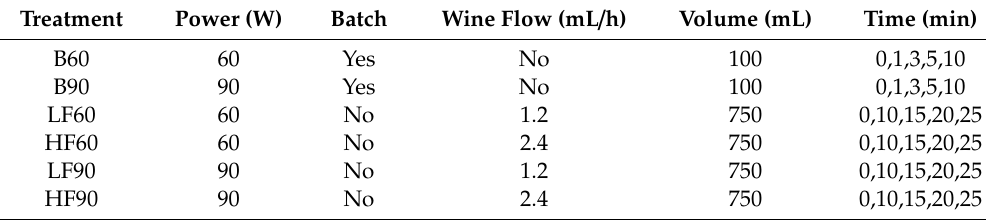
Figure 1. Schematic representation of ( a ) batch Atmospheric Pressure Cold Plasma (APCP) treatments and of ( b ) continuous APCP treatments. Table 1. Argon APCP treatments in batch (B) and low flow (LF) and high flow (HF) systems (F) characteristics.